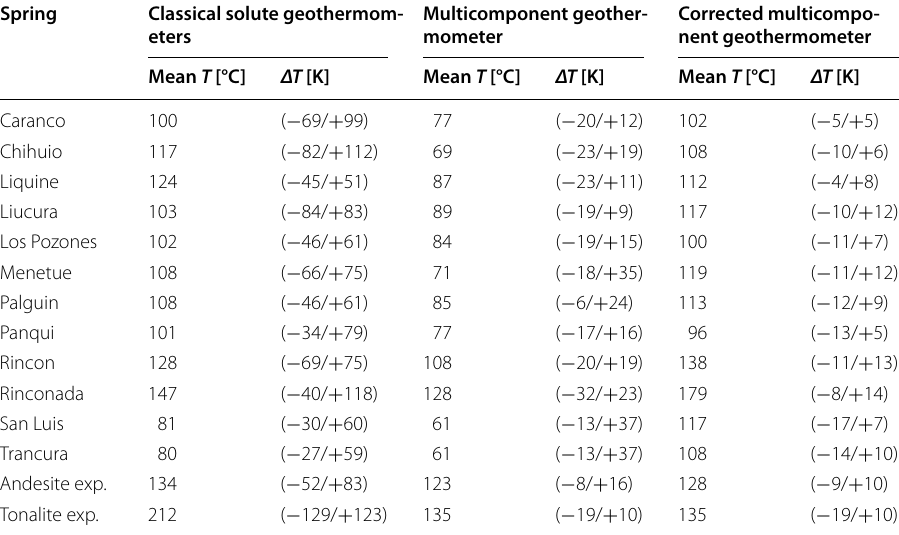
Table 3 Mean in situ temperatures for Villarrica springs and laboratory experiments cal- culated by a suite of classical solute geothermometers, multicomponent geothermometry and pH/aluminum-corrected multicomponent geothermometry Spring Classical solute geothermom- Multicomponent geother- Corrected multicompo- eters mometer nent